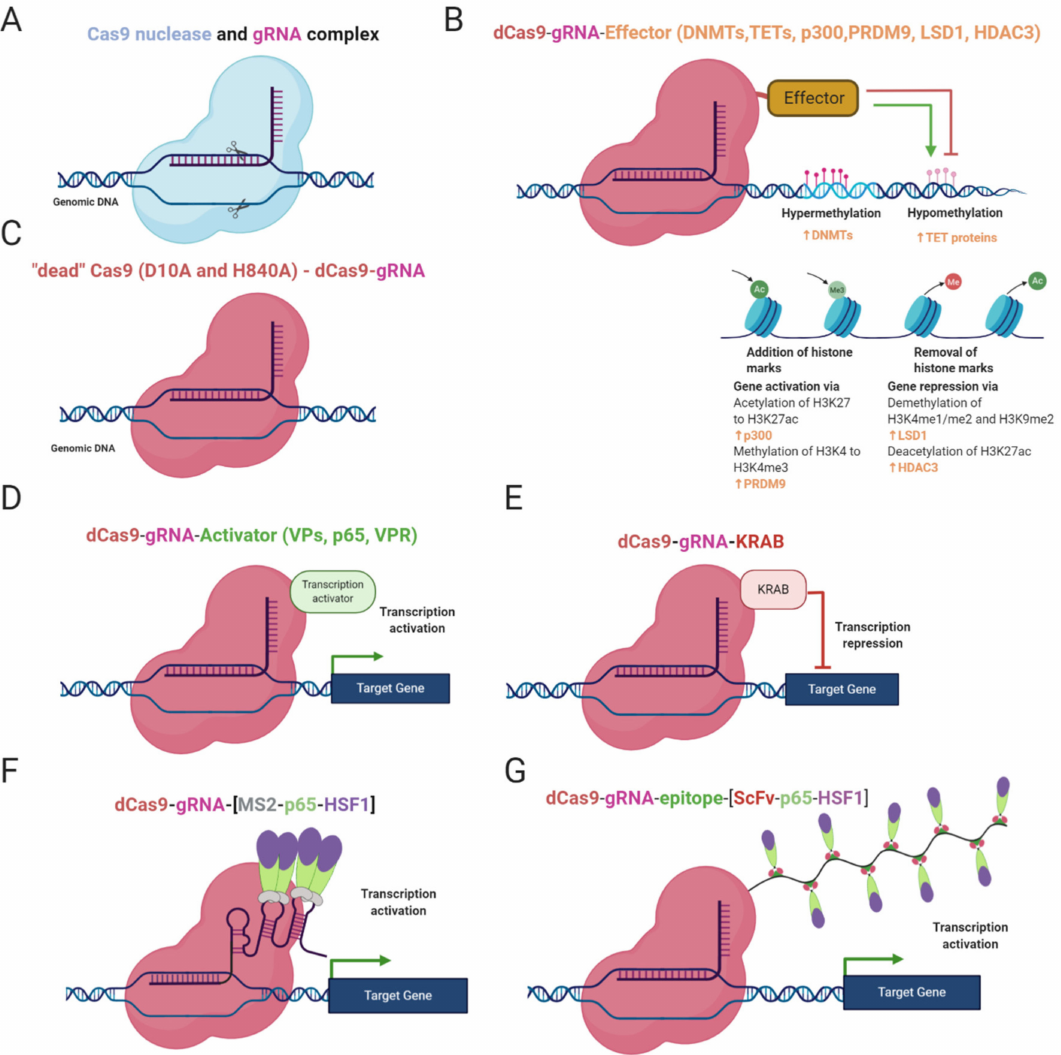
Figure 1. Epi-editor systems and their constitution. ( A ) Cas9 nuclease executing site-specific DSB; ( B ) dCas9 protein with e ff ector domain of DNMTs or TETs or p300 or PRDM9 or LSD1 or